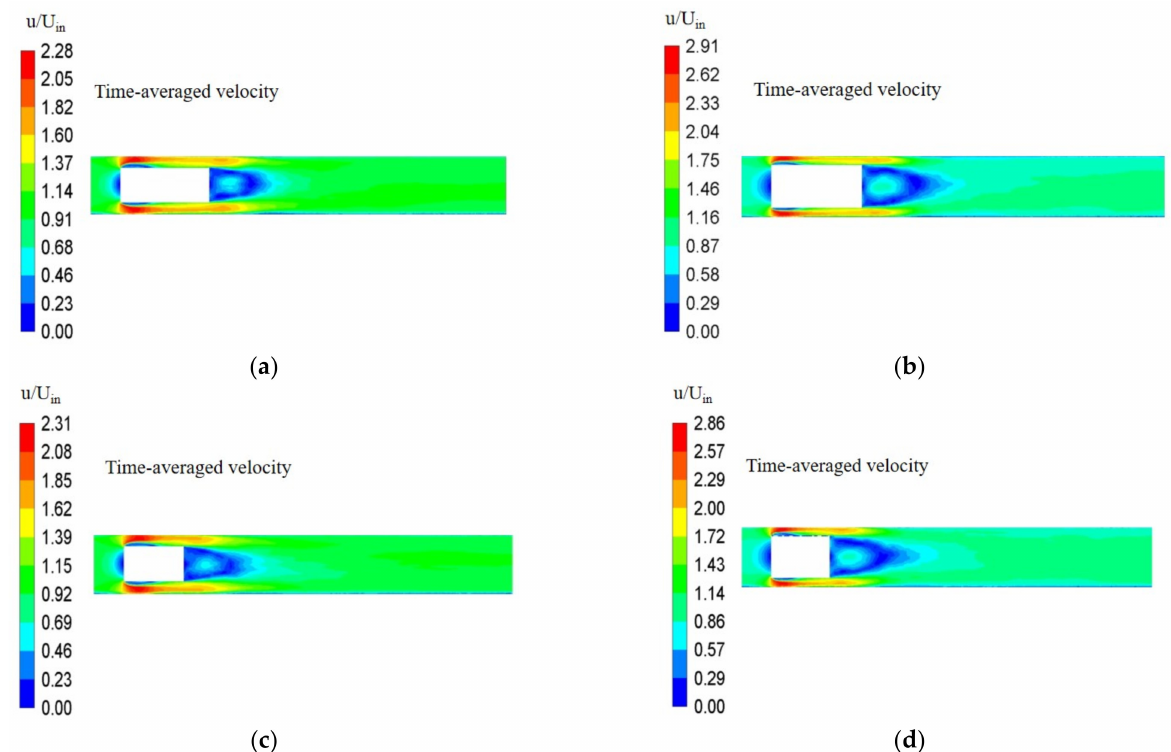
Figure 9. Dimensionless, time-averaged velocity distribution cloud in XZ plane: ( a ) K = 0.4; ( b ) K = 0.5; ( c ) K = 0.6; ( d ) K =